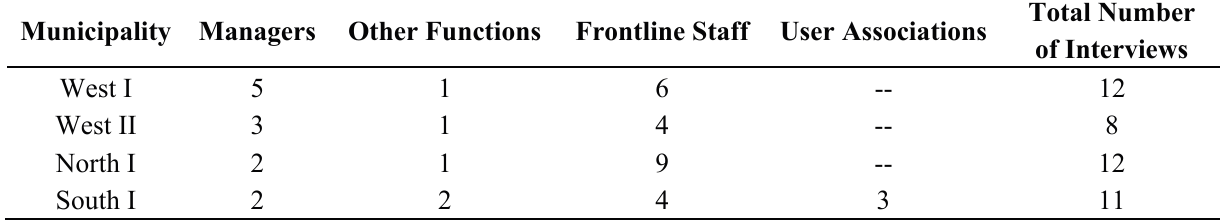
Table 3. Description of the collected data. Interviews at four sites.